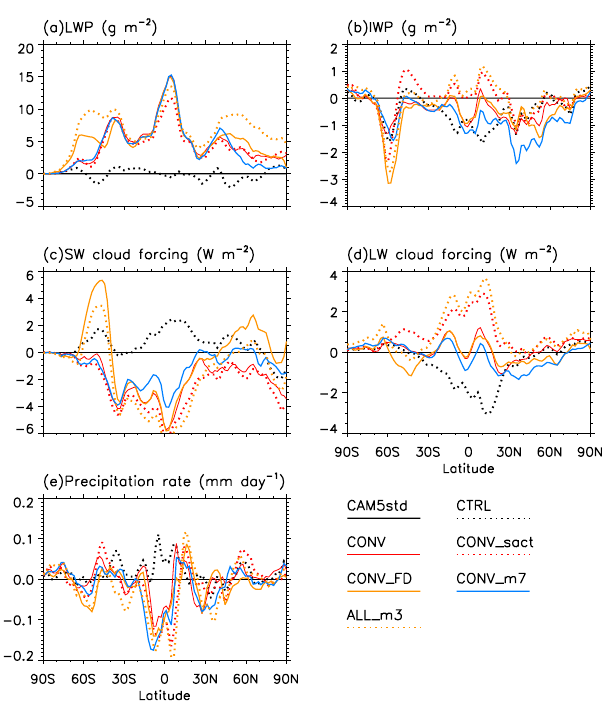
Fig. 9. Meridional variation of annual mean differences (sen- sitivity simulation minus CAM5std) of (a) liquid water path (LWP,gm − 2 ) , (b) ice water path (IWP,gm − 2 ) , (c) total precipi- tation rate (mmday − 1 ) , (d) shortwave cloud forcing, and (e) long- wave cloud forcing for the various